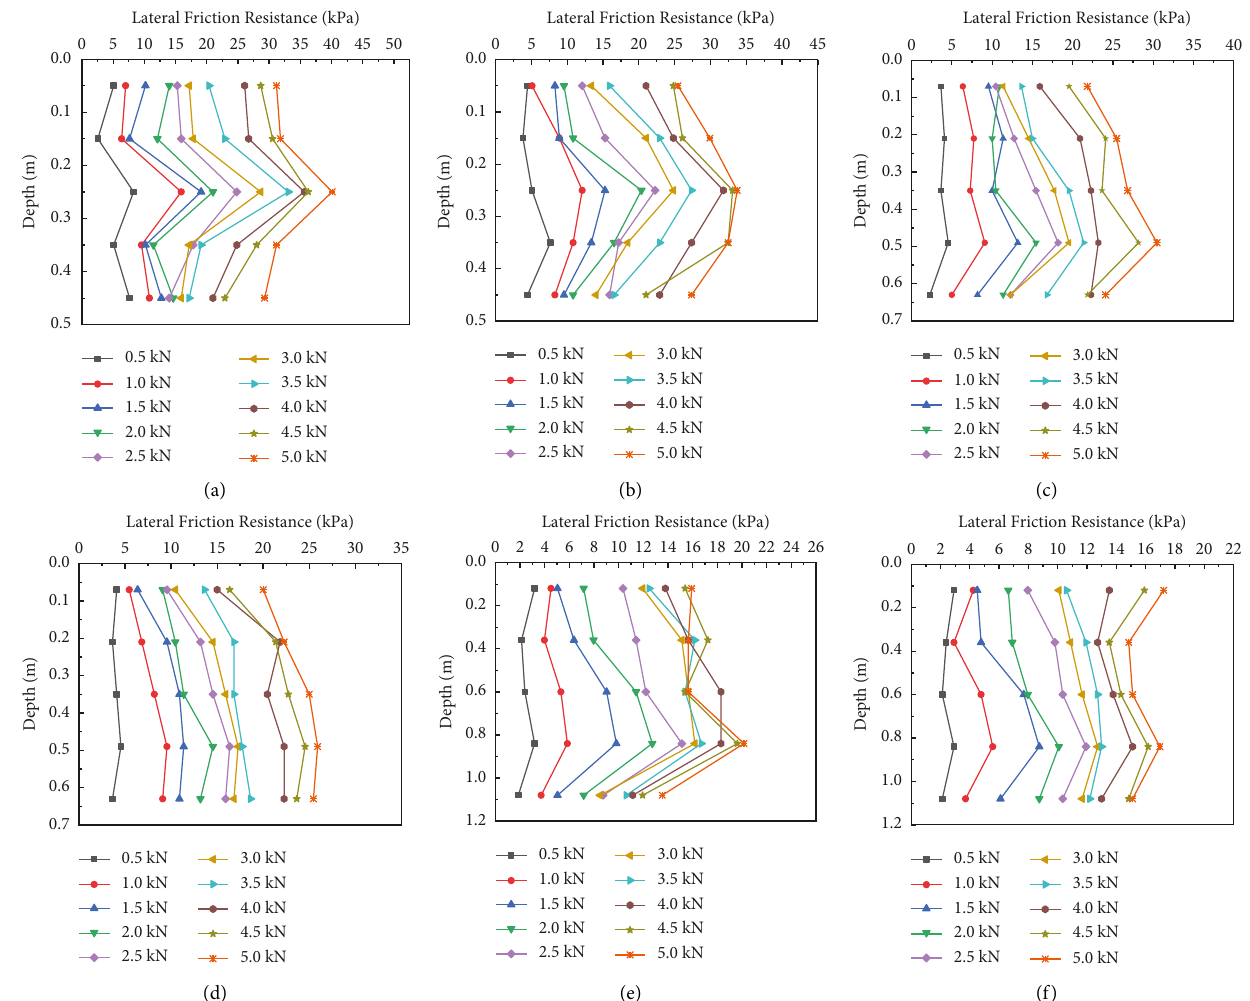
Figure 9: Lateral friction resistance curves of model piles. (a) M0. (b) M1. (c) M2. (d) M3. (e) M4. (f)